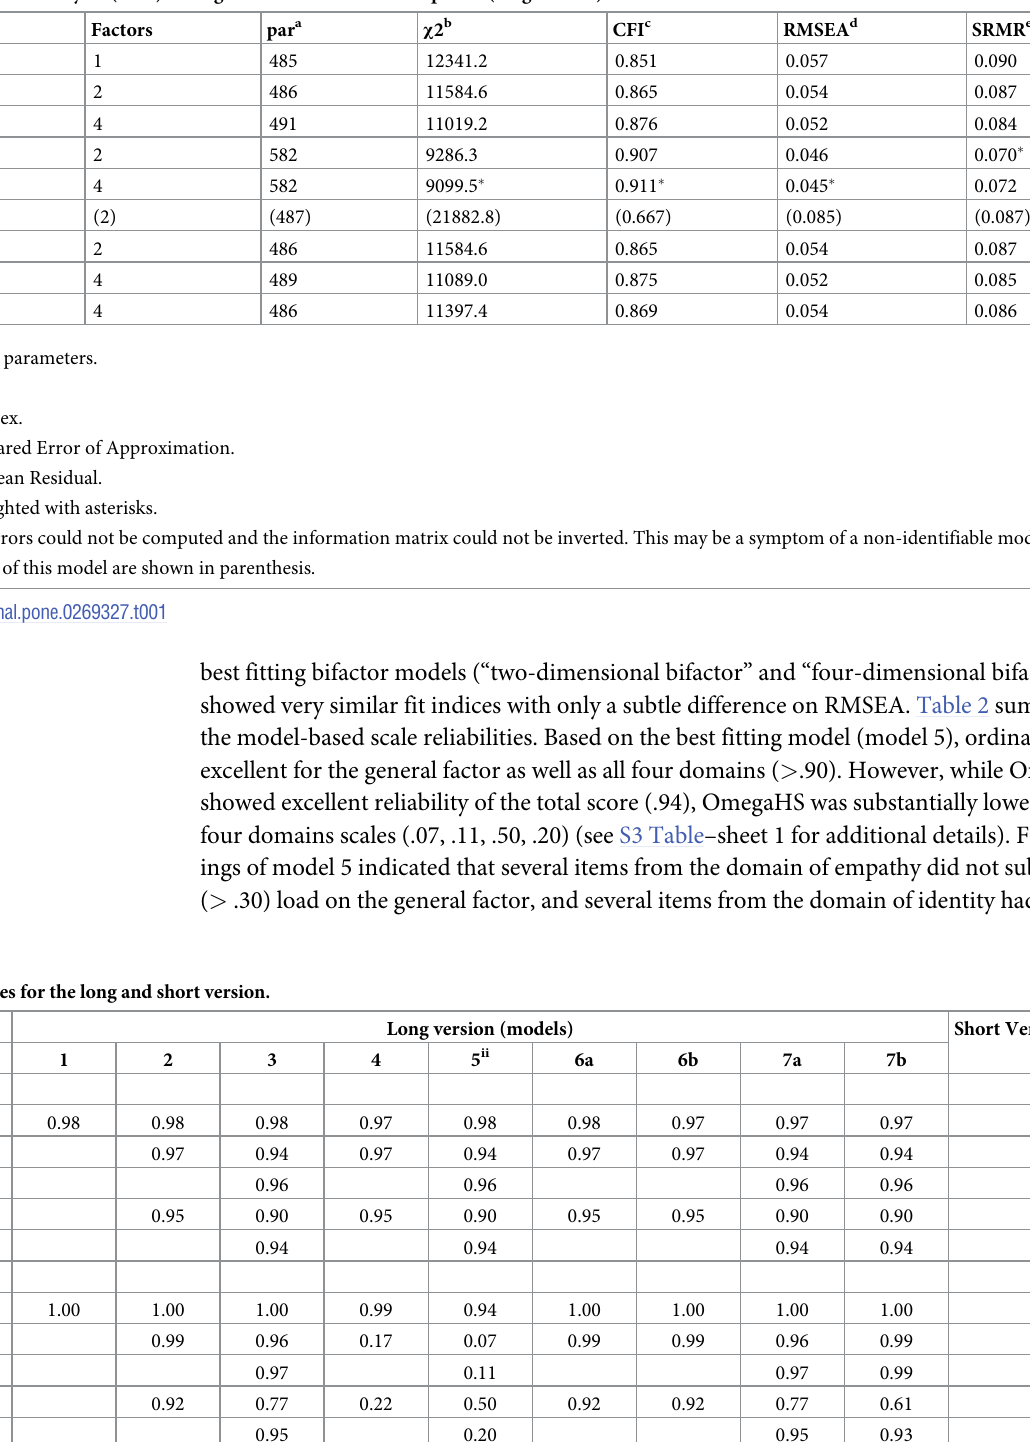
Table 1. Confirmatory factor analyses (CFA) testing different factorial assumptions (long version).